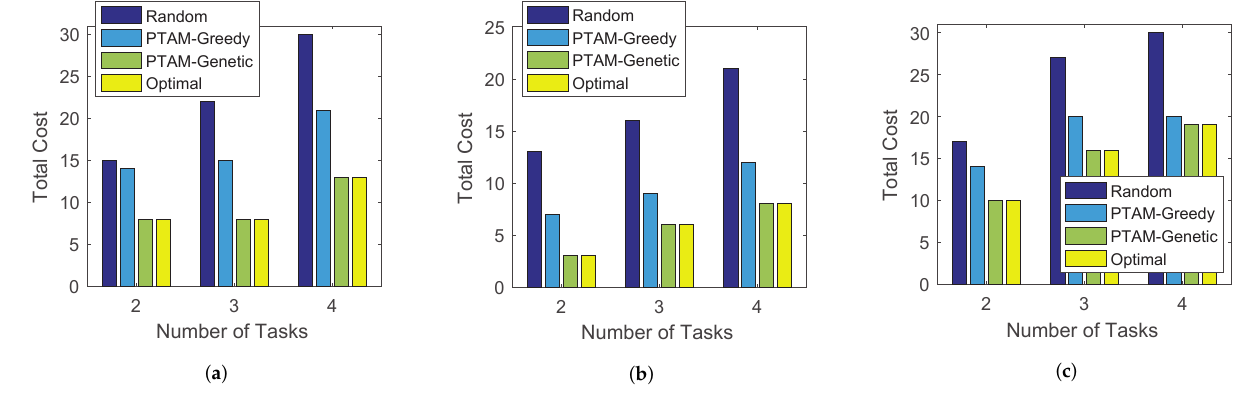
Figure 13. Performance comparisons on the three real-world data sets. ( a ) roma/taxi trace set. ( b ) epfl trace set. ( c ) geolife trace